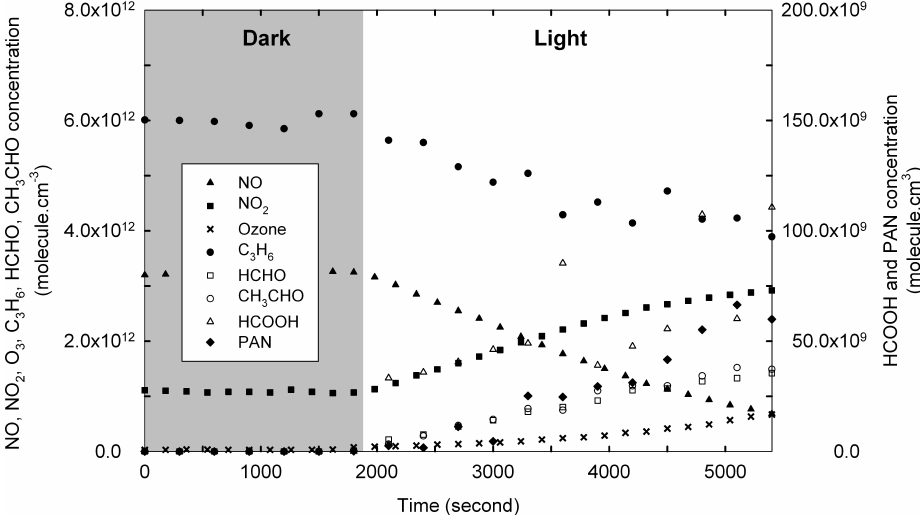
Fig. 7. Concentration-time profiles of NO x , ozone, propene, HCHO, HCOOH, CH 3 CHO, and PAN in a C 3 H 6 -NO x -Air system.